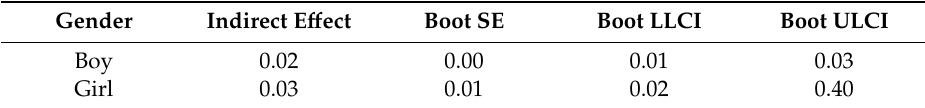
Table 3. Conditional indirect e ff ect of mother smartphone dependency on adolescent smartphone dependency through negative parenting by adolescent gender.